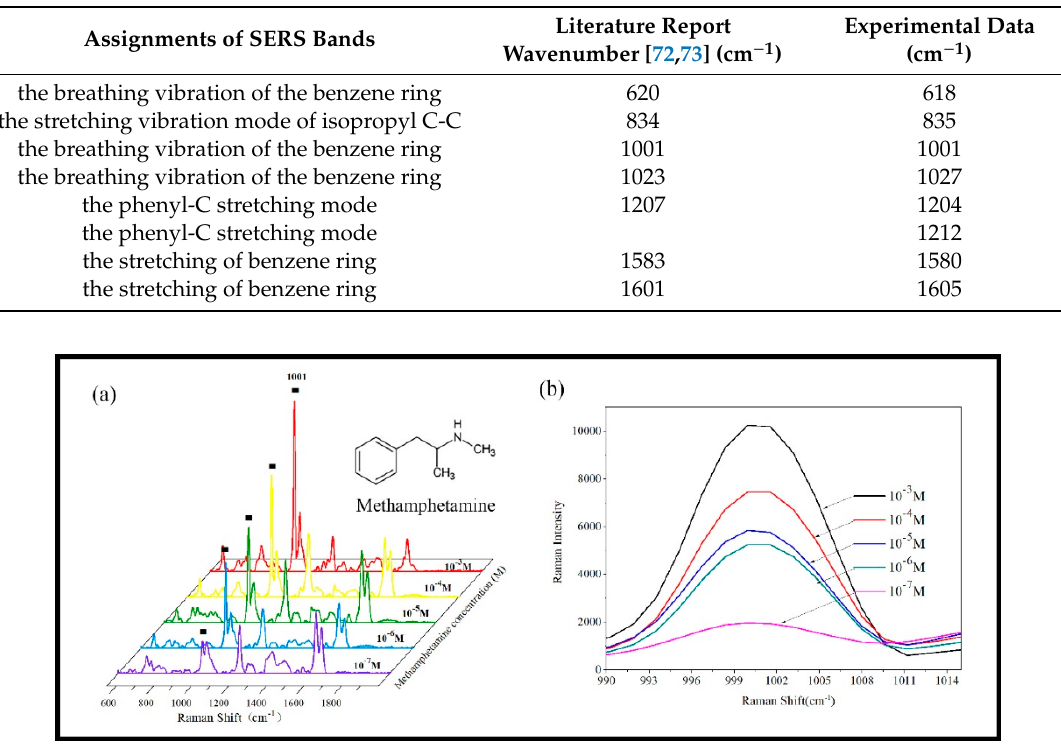
Figure 12 . ( a ) The SERS spectra of AuNRs arrays substrate measured with various of Figure 12. ( a ) The SERS spectra of AuNRs arrays substrate measured with various of methamphetamine; methamphetamine; ( b ) the drawing of partial enlargement at the vibration bands of 1001 cm − 1 . ( b ) the drawing of partial enlargement at the vibration bands of 1001 cm − 1